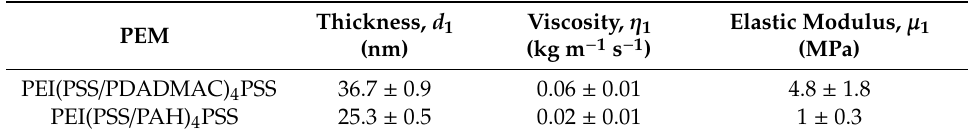
Table 2. The average thickness, viscosity and elastic modulus of hydrated PEI(PSS / PADMAC) 4 PSS and PEI(PSS / PAH) 4 PSS multilayers obtained from the Kelvin-Voigt modeling.